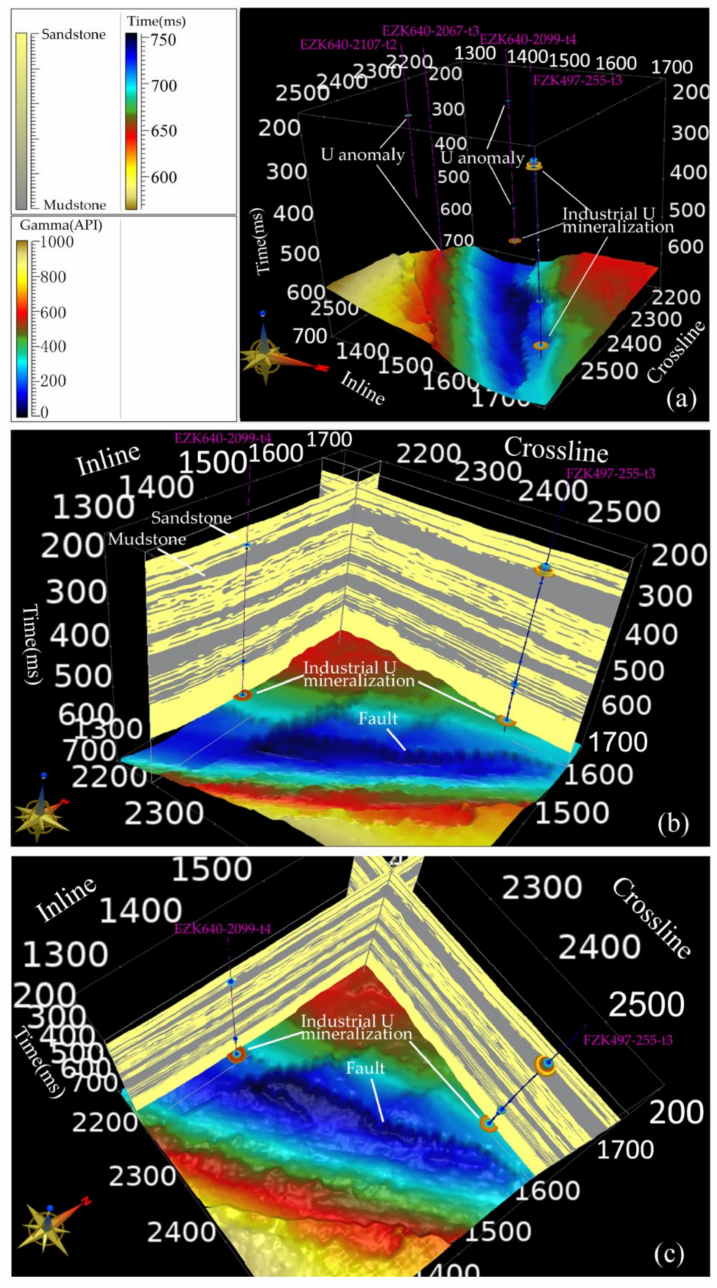
Figure 12. Three-dimensional distribution of the K 1 s bottom boundary and gamma logging ( a ), lateral view of K 1 s bottom boundary and the rock lithological profiles of the upper part of the K 1 s FM ( b ), top view of 3D distribution map ( c ); the yellow represents sandstone and the gray represents mudstone in the two cross profiles. Red and yellow circles represent high gamma values, and blue circles represent low gamma values; in the 3D surface map, the yellow represents shallow burial depth and the blue means great depth; the two industrial U mineralization boreholes, FZK495-255-t3 and FZK495-2099-t4, located in the fracture and depression sections; the U abnormal hole of EZK640- 2067-t3, and the normal borehole of EZK640-2107-t2 are located where there are no fractures or depression